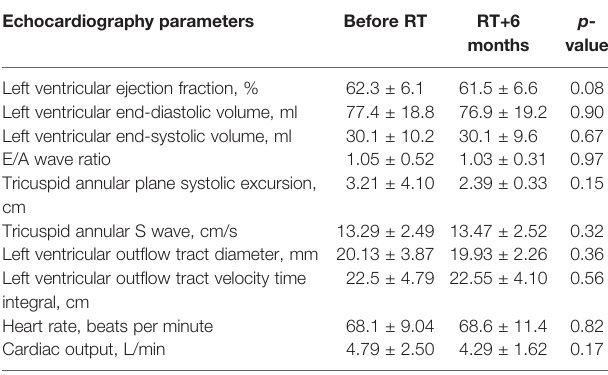
TABLE 3 | Description of conventional echocardiography parameters before RT and RT+6 months. Echocardiography parameters